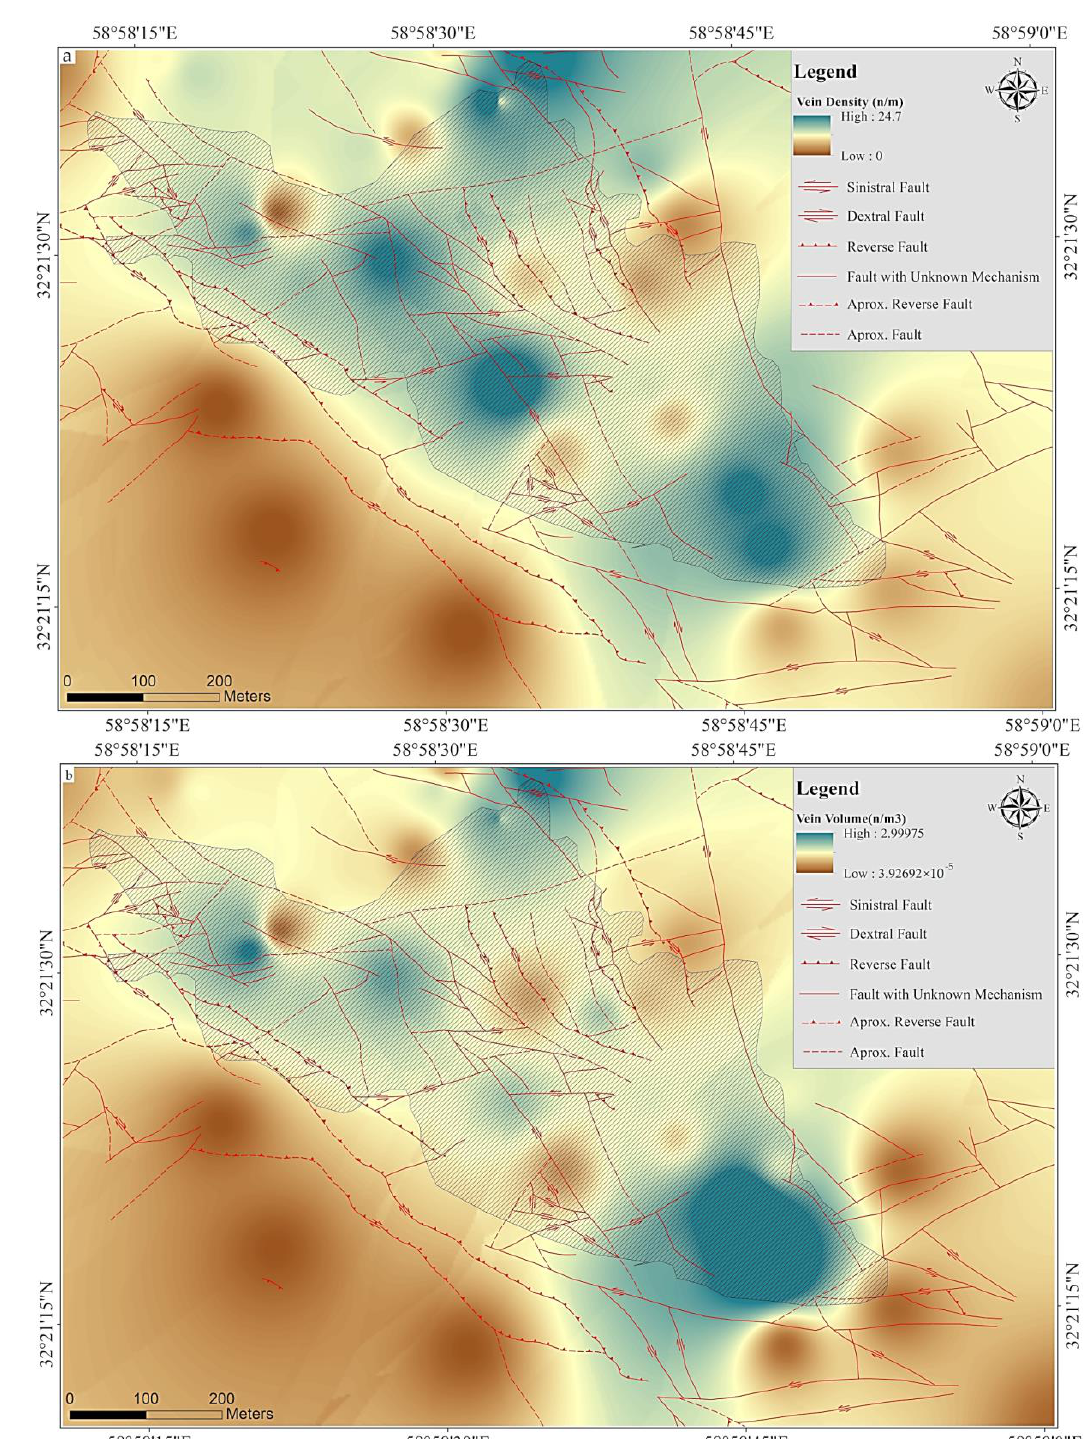
Figure 9. ( a ) Contour plot of the total vein frequency per meter of quartz veins at Shadan; ( b ) contour plot of the total vein volume per cubic meter of quartz veins. The crosshatching is the zone with mineralized veins.